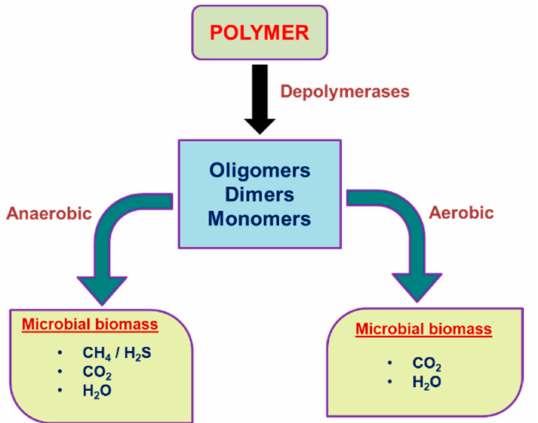
Figure 2. Scheme of polymer degradation under aerobic and anaerobic